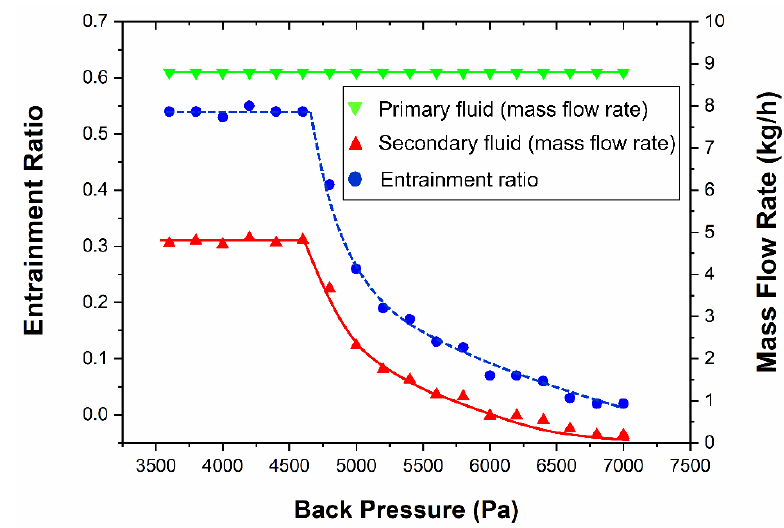
Figure 15. Comparison of entrainment ratio and the mass flow rate of two streams under different back pressure.